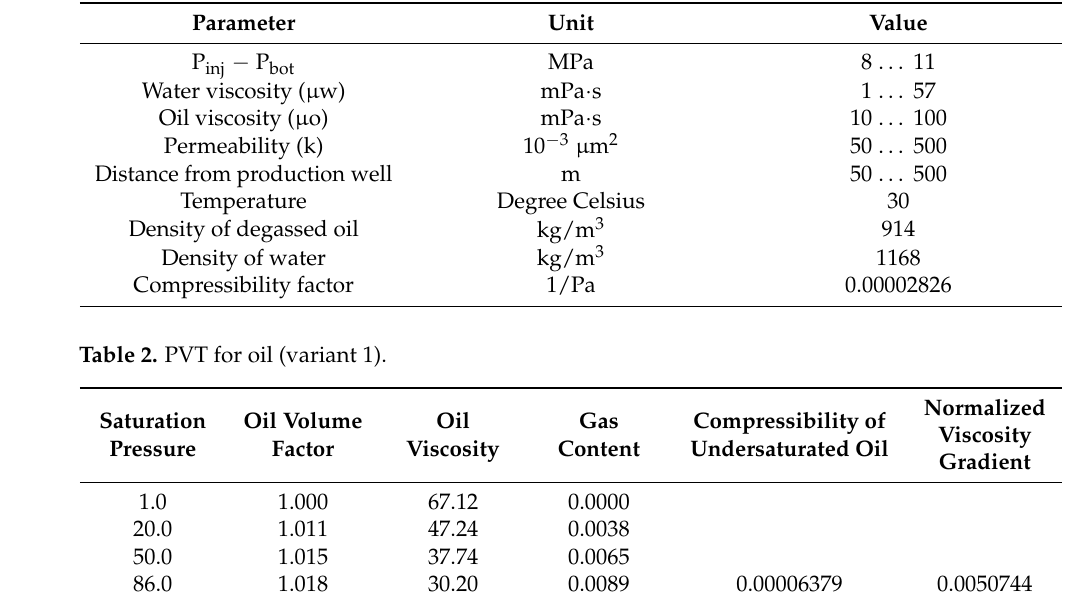
Table 1. Initial data for modeling.